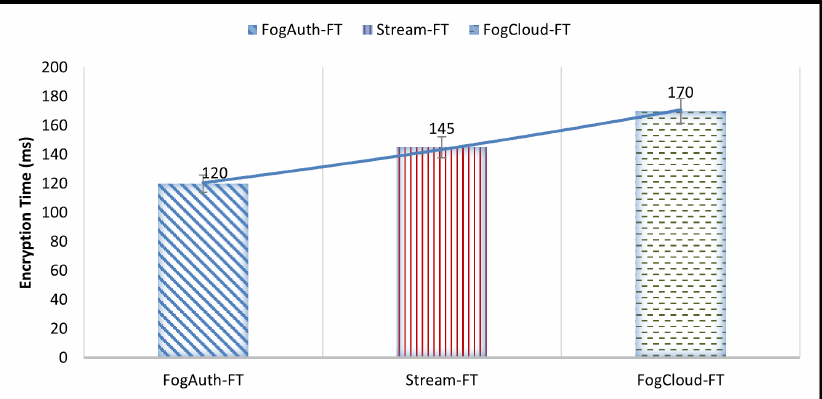
Figure 5. Encryption time with key size 256 bit and block size 192